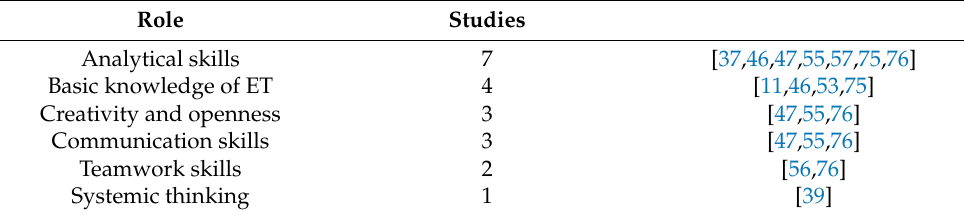
Table 5. Impacts on accountants’